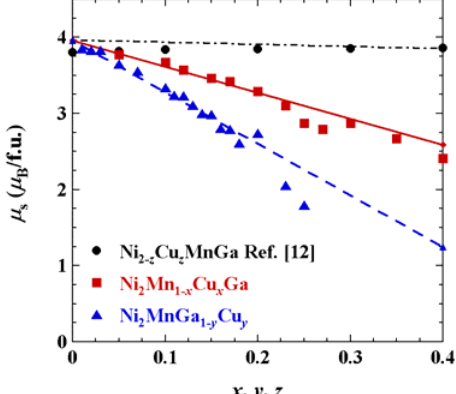
Figure 5. Concentration dependence of the magnetic moment per formula unit, μ Mn Cu Ga (0 ≤ x ≤ 0.40), Ni Ni 2 1 − x x (0 ≤ z ≤ 0.40). All values of μ Ni Cu MnGa (0 ≤ z ≤ 0.40) alloys. They were estimated at 4.2 K 2 − z z